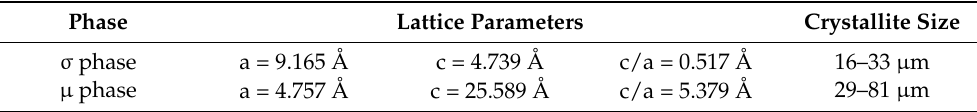
Figure 5. ( a ) Load-depth curves for the FCC solid solution, σ and μ phases in the Mo x HEA for the maximum load of 10 mN and ( b ) a given SEM backscattering image of these indents for Mo1. Table 3. The nano-hardness of the prepared materials in different phases .